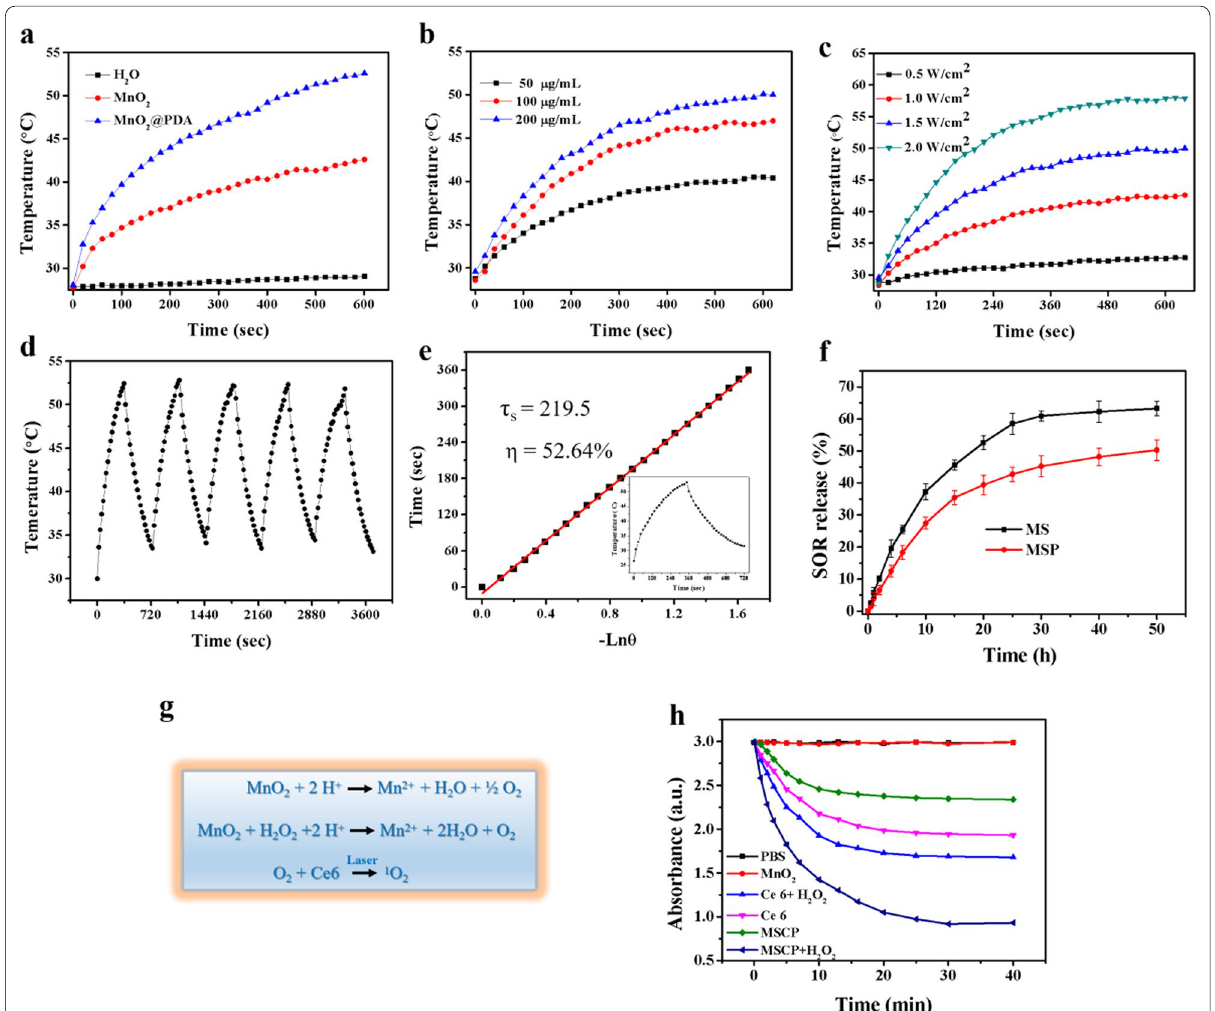
Fig. 2 a Temperature increase versus irradiation duration curves of H 2 O, MnO 2 (100 μg mL − 1 ), and MnO 2 @PDA (100 μg mL − 1 ) at irradiation with an 808 nm laser (2 W cm − 2 ). b Temperature increase versus irradiation duration curves of MSCPF at different doses (50, 100, 200 μg mL − 1 ) at power density of 1.5 W cm − 2 . c Temperature increase versus irradiation duration curves of MSCPF (200 μg/mL) at different power density (0.5, 1.0, 1.5, 2.0 W cm − 2 ). d Heating/cooling profiles of MSCPF after five on–off laser irradiation cycles (808 nm, 1.5 W/cm 2 ). e Linear data of cooling time versus driving force temperature for MSCPF, with calculated PCEs of 52.64%. f Triggered release profiles of SOR from MnO 2 -SOR, or MnO 2 -SOR @ PDA in Tris–HCl solution containing 5% Tween 80 and 100 μM H 2 O 2 (pH 5.5). g Schematic diagram of singlet oxygen produced by MnO 2 . (h) ROS production profiles of PBS, MnO 2 , Ce6, MSCP, Ce6 H 2 O 2 , MSCP H 2 O 2 under laser irradiation (660 nm, 500mW cm − 2 ) measured by UV–vis with + + 9,10-anthracenediyl-bis(methylene) dimalonic acid (ABDA) as a ROS